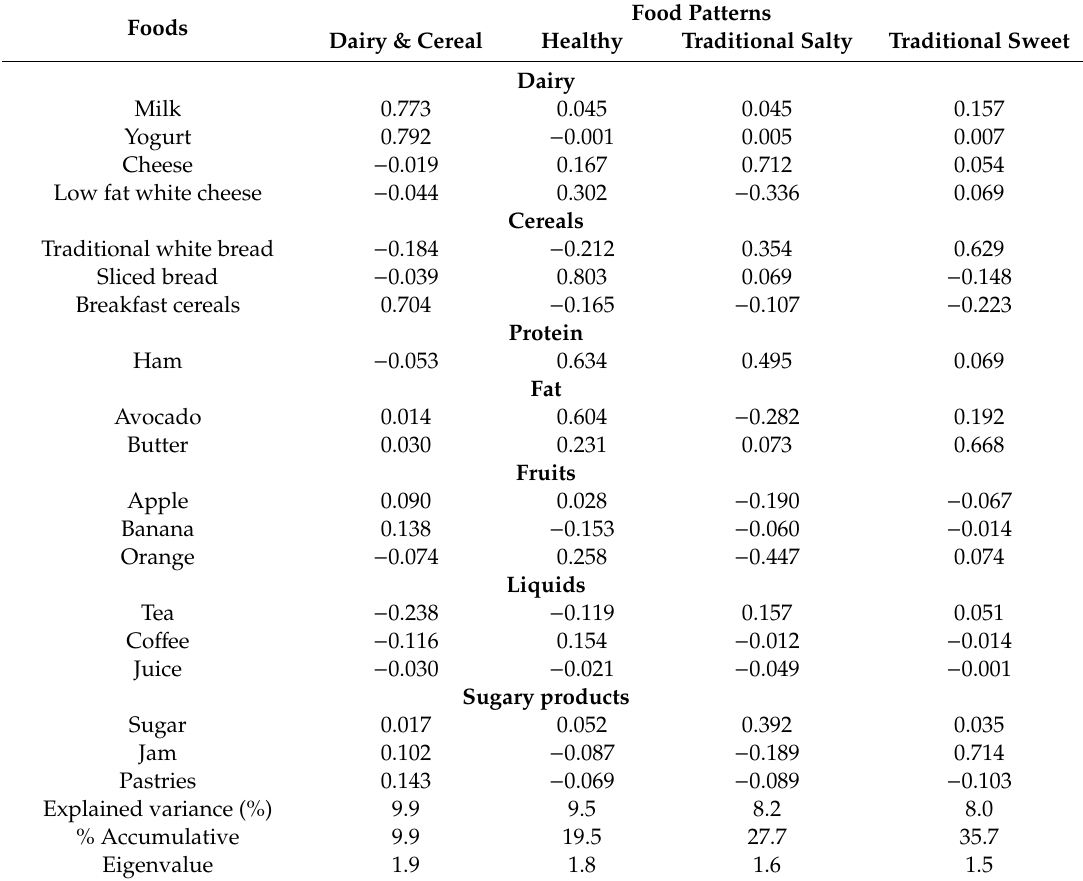
Table 3. Factor loadings for breakfast patterns according to consumed food reported by Chilean university